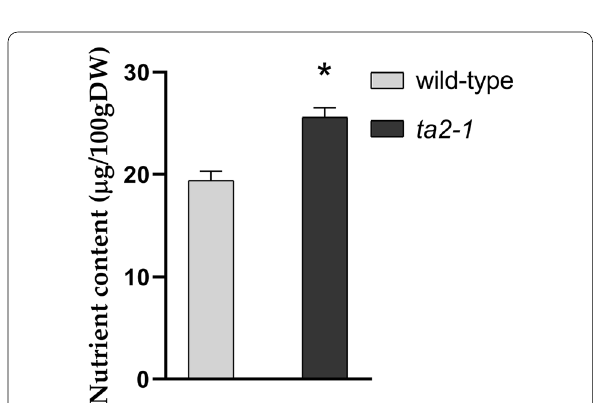
Fig. 8 Folate (Vitamin B9) content comparison (* P < 0.05; ANOVA, Tukey’s HSD test; n 3) =